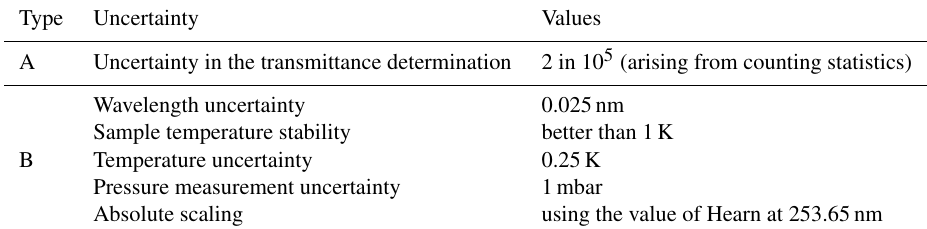
Table 2. Absolute uncertainties reported by Bass and Paur (1985) and Paur and Bass